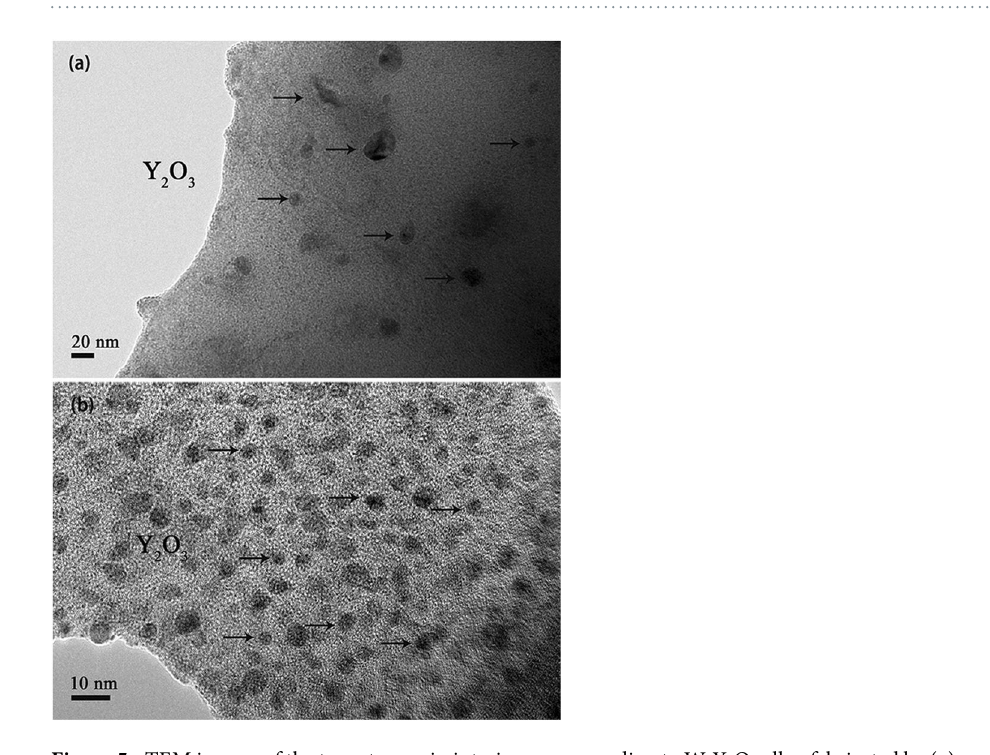
Figure 5. TEM images of the tungsten grain interior corresponding to W-Y 2 O 3 alloy fabricated by ( a ) traditional wet chemical method and subsequent SPS and ( b ) improved wet chemical method and subsequent